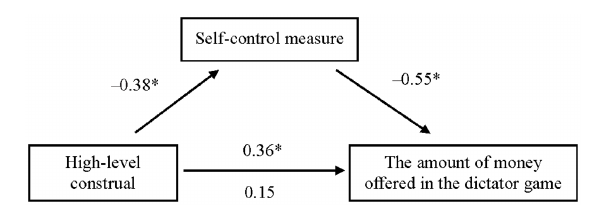
FIGURE 2 | Mediation of the effect of exposure to “why” questions (high-level construal) regarding morality on the amount of money offered in the dictator game in Experiment 2. Values are standardized regression coefficients. The self-control measure was indexed as the mean difference in reaction time (ms) between incongruent and congruent trials in the Stroop task. Less Stroop interference indicates a state of greater self-control. On the lower path, the values below and above the arrow are the results of analyses in which the mediator was and was not included in the model, respectively. Asterisks indicate significant results ( p <